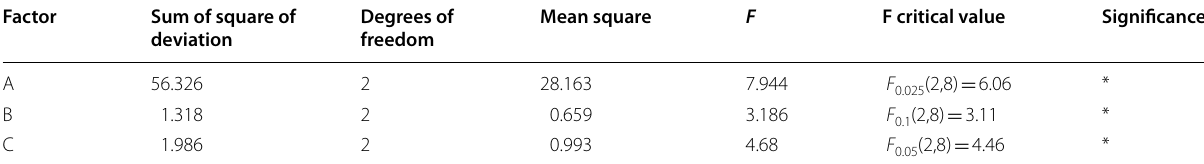
Table 14 ANOVA of the results of the 33 d compressive strength test Factor Sum of square of Degrees of Mean deviation freedom